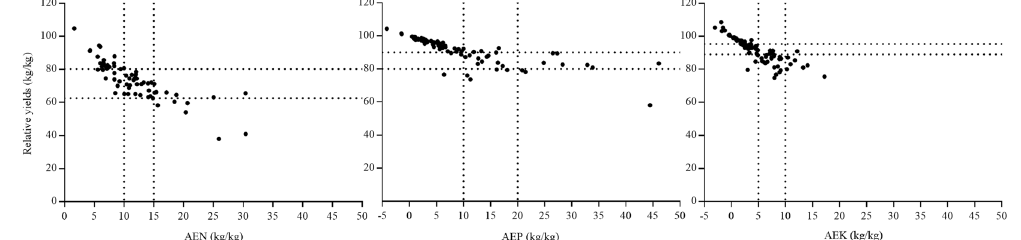
Figure 8. Relationships between relative yield (the proportion between nutrient-limited yield and attainable yield with optimal fertilization) and agronomic efficiencies of N, P and K (AEN, AEP and AEK, respectively) in the rice cultivation field experiments in southeast China that provided the data used in this